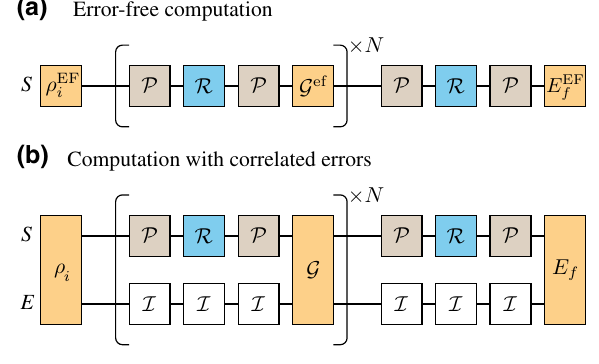
FIG. 13. The computing without and with errors. From left to right, R = R 1 , R 2 , . . . , R N + 1 , P = P 1 , P 2 , . . . , P 2 N + 2 , G EF = G EF , G EF , . . . , G EF , and G = G 1 , G 2 , . . . , G N . Here I = [ 1 E ] is N 1 2 the identity map on the environment; S denotes system and E denotes